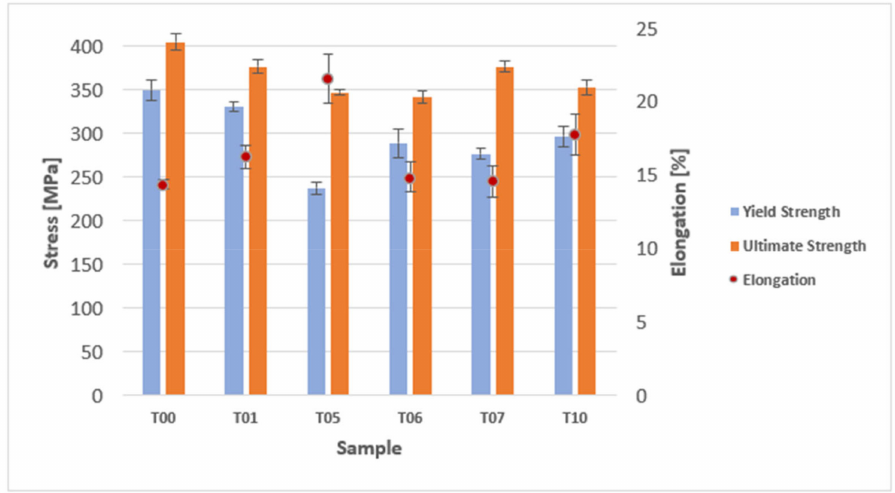
Figure 6. Results of the tensile tests performed at high temperature.